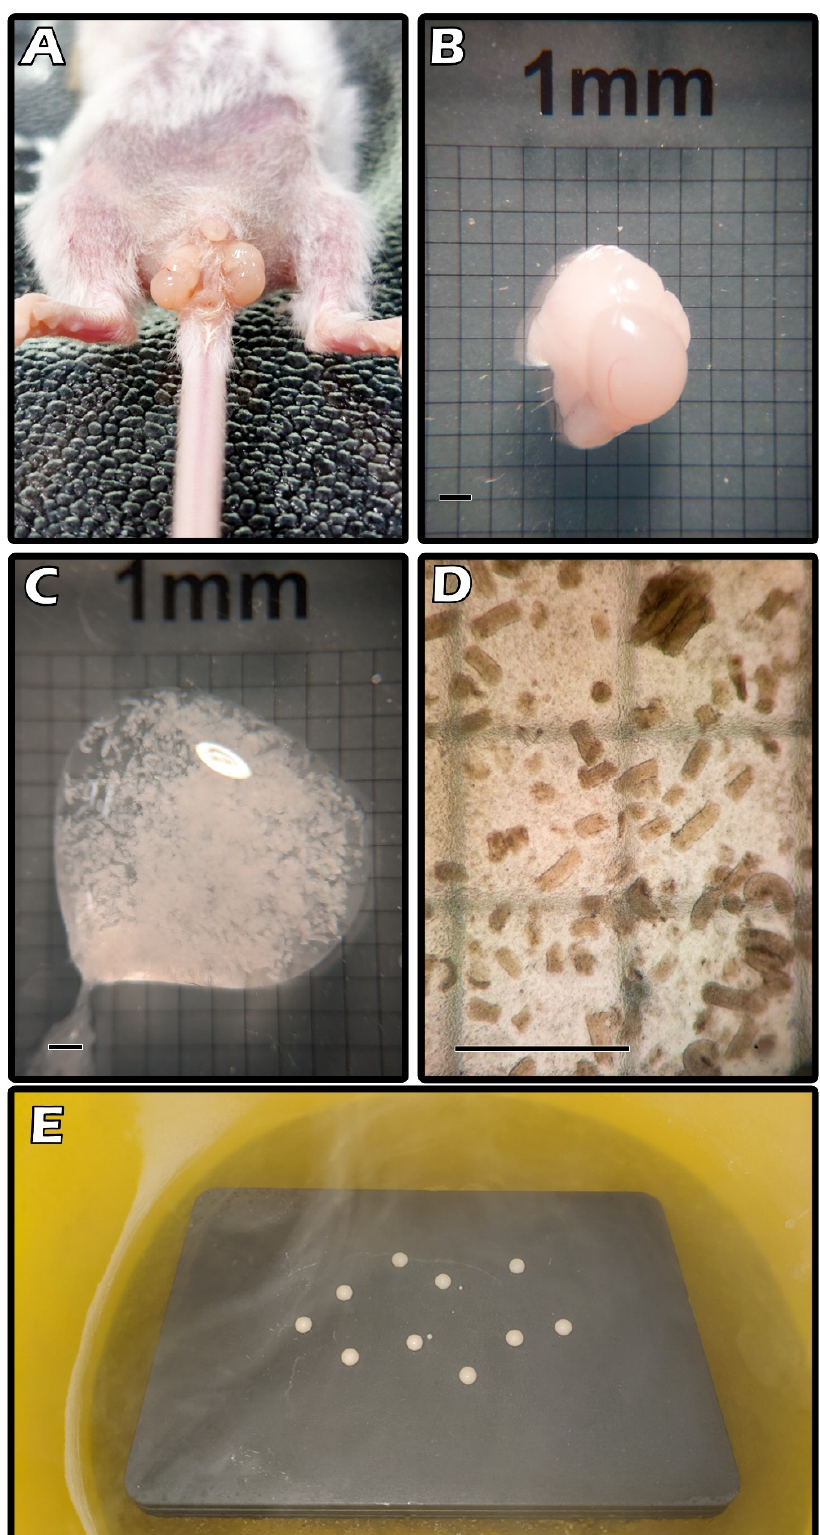
Figure 2. Exposed the testis from the scrotum ( A ). Each testis measured about 4 × 3 × 3 mm 3 ( B ). Fragmented ITT tissues ( C ). Each fragment size was approximately 0.29 mm × 0.12 mm on average ( D ). Multiple CPA droplets on a metal cube with partial LN 2 immersion during the SSV procedure ( E ).